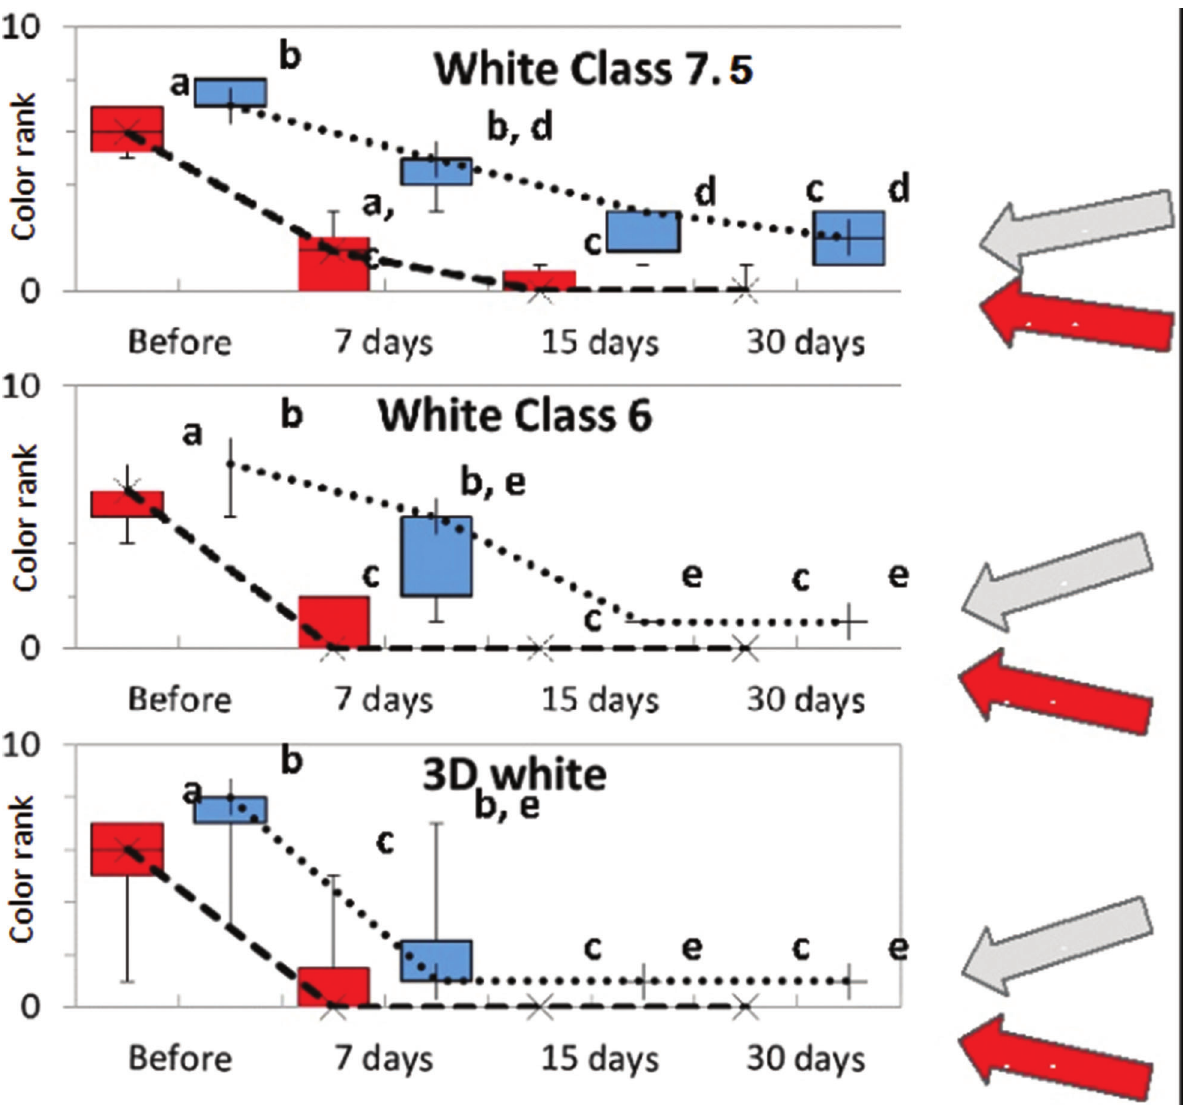
Figure 2 - (color online) Boxplot of all groups: White class 7.5 (top), White class 6 (middle) and 3D White (bottom). Red boxes with ---X--- represent incisors, and blue boxes with (cid:1)(cid:1)(cid:1)(cid:1)(cid:1) + (cid:1)(cid:1)(cid:1)(cid:1)(cid:1) represent canines. The same letters denote statistically equal color ranks. White Class 7.5 required 30 days of treatment to stabilize the color rank of the teeth. The median color rank for the 3 (1M2 - 2M2), while the median rank color for the incisors was 0 (1M1), with subjects varying up to 1 (1M2). Although, a small decrease was found in the median color rank 30 days after treatment, the difference did not achieve statistical